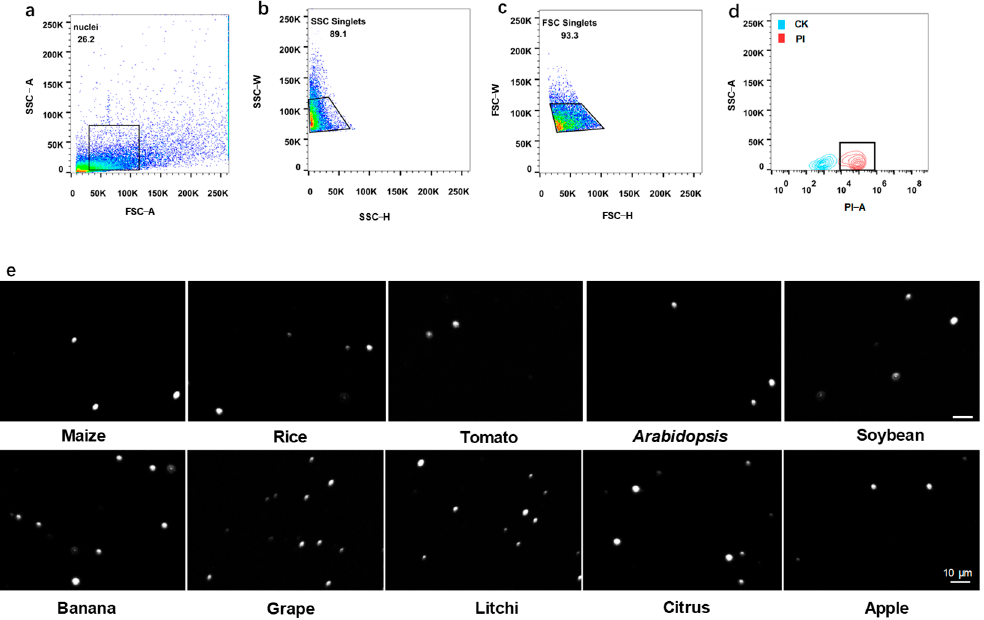
Figure 3. Logic diagram of nuclear quality control using flow cytometry and images of sorted nuclei. ( a ) Dot plot of size position of nuclei selected by FSC versus SSC. ( b ). SSC single nuclei collected by SSC-height versus SSC-width. b plot produce based on the rectangular part of a plot. ( c ) FSC single nuclei collected by FSC-height versus FSC-width. Plot c produce based on the trapezoidal section of b plot. ( d ) Contour plot of PI positive nuclei (red) and control nuclei (blue). Plot d produce based on the trapezoidal section of plot c. ( e ) Sorted nuclei observed under BD Rhapsody™ Scanner from maize, rice, tomato, arabidopsis, soybean, banana, grape, litchi, citrus, and